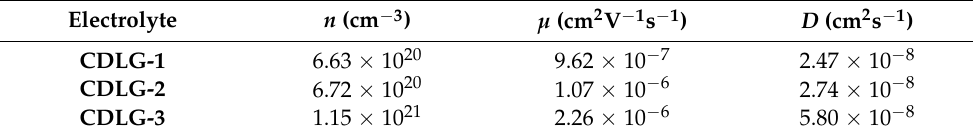
Table 2. Ion transport parameter from impedance